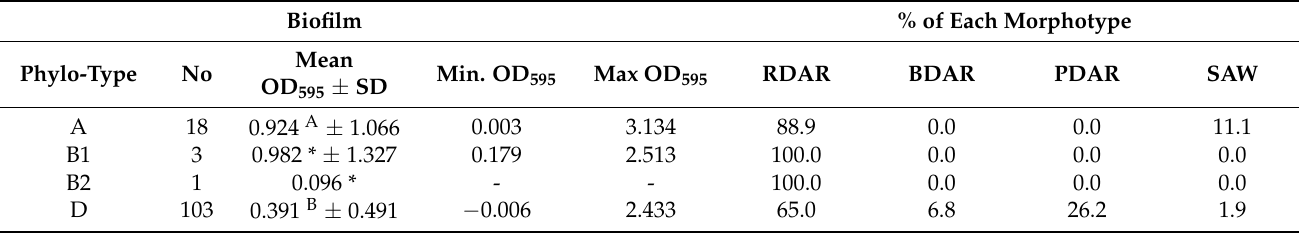
Table 4. Biofilm production by ESCR E. coli strains as indicated by OD 595 in the crystal violet biofilm assay, as well as distribution of morphotypes within each phylotype.